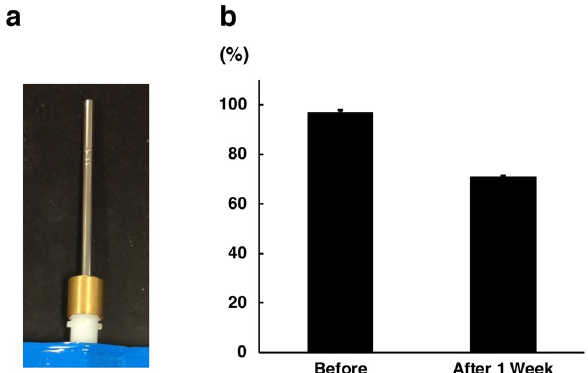
Figure 1. Preservation of H 2 concentration in H 2 water. ( a ) To maintain a high concentration of H 2 in water, we developed water drinking valves. ( b ) The hydrogen concentration was 96.84 ± 1.03% before drinking and 70.68 ± 0.31% 1 week after drinking (C57BL/6J mice, n = 4). Bars depict mean ± standard deviation